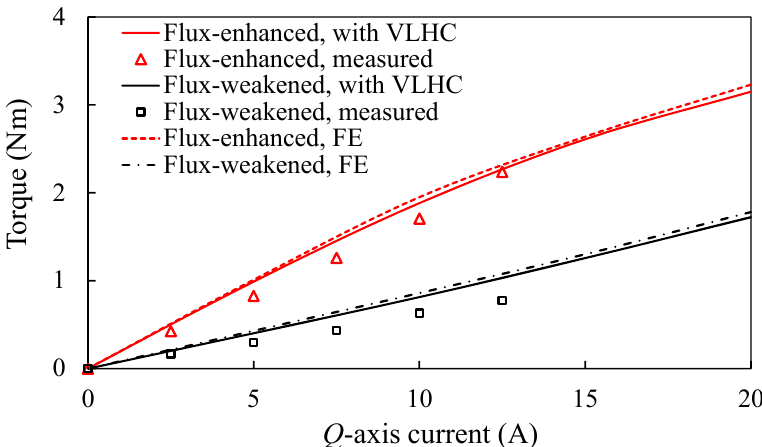
Figure 17. Comparison of FE-predicted and measured torque against q -axis current characteristics.